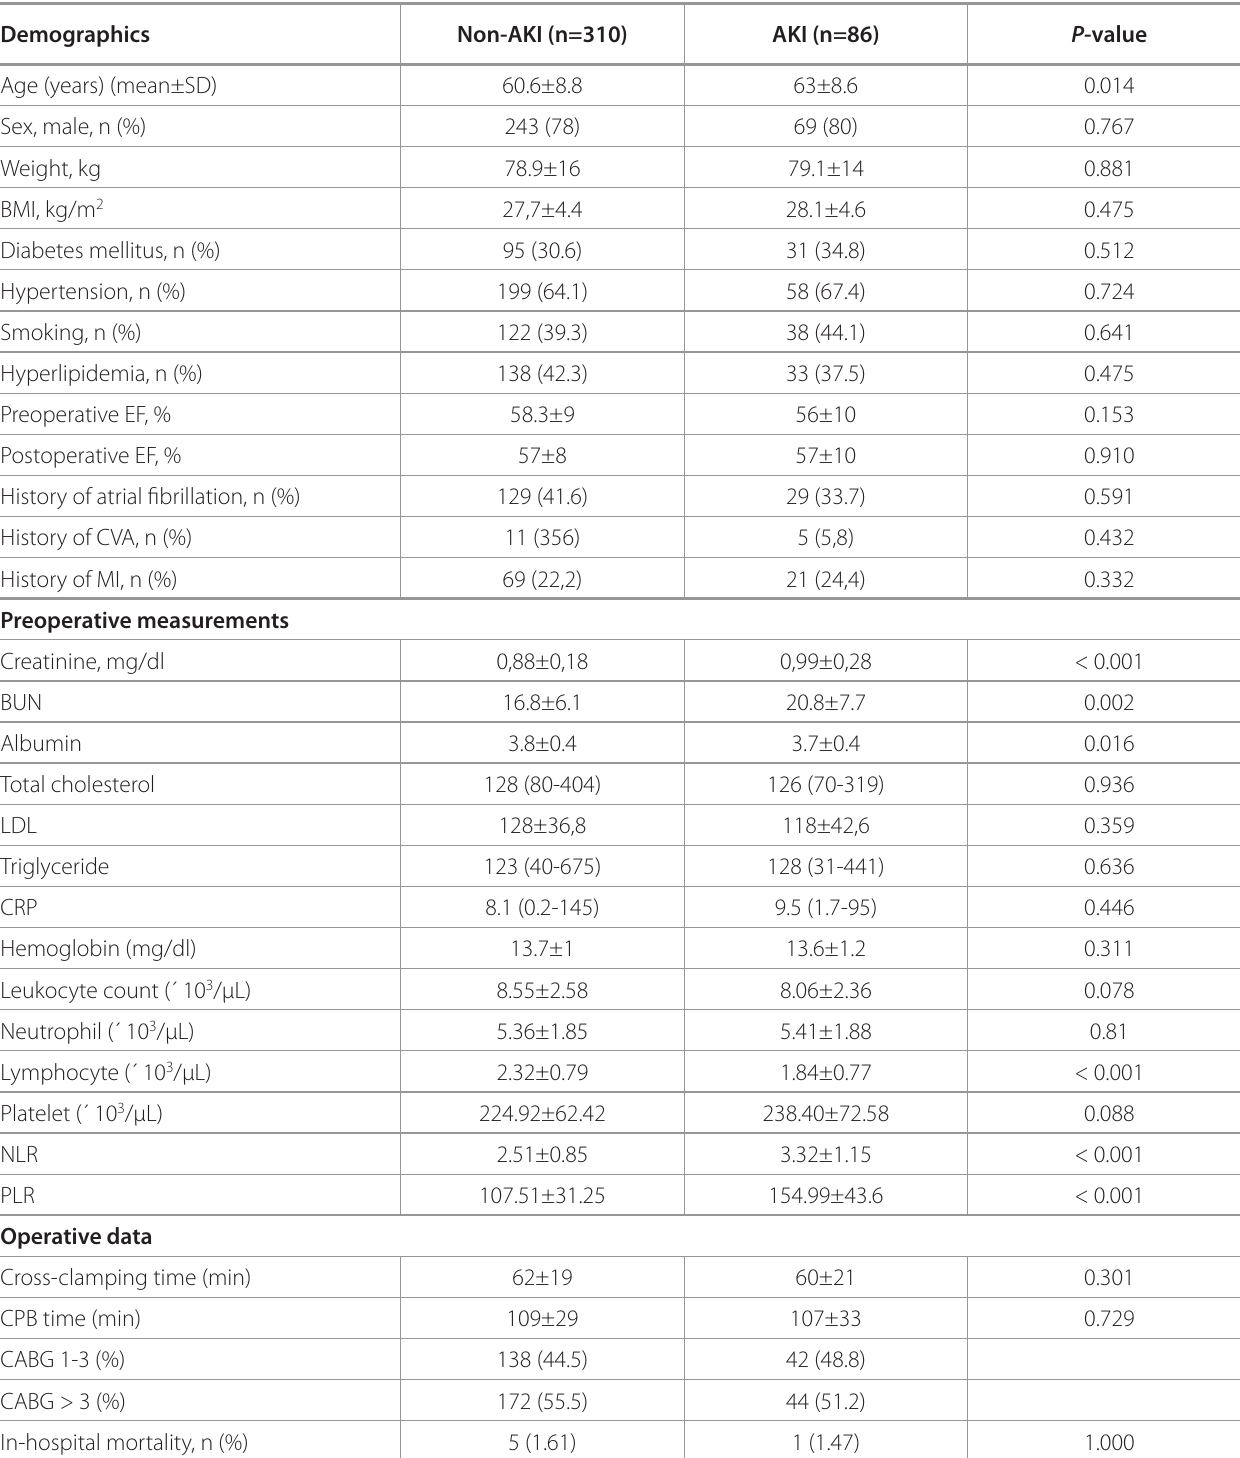
Table 1 . Demographics, preoperative laboratory results, NLR and PLR values, and operative